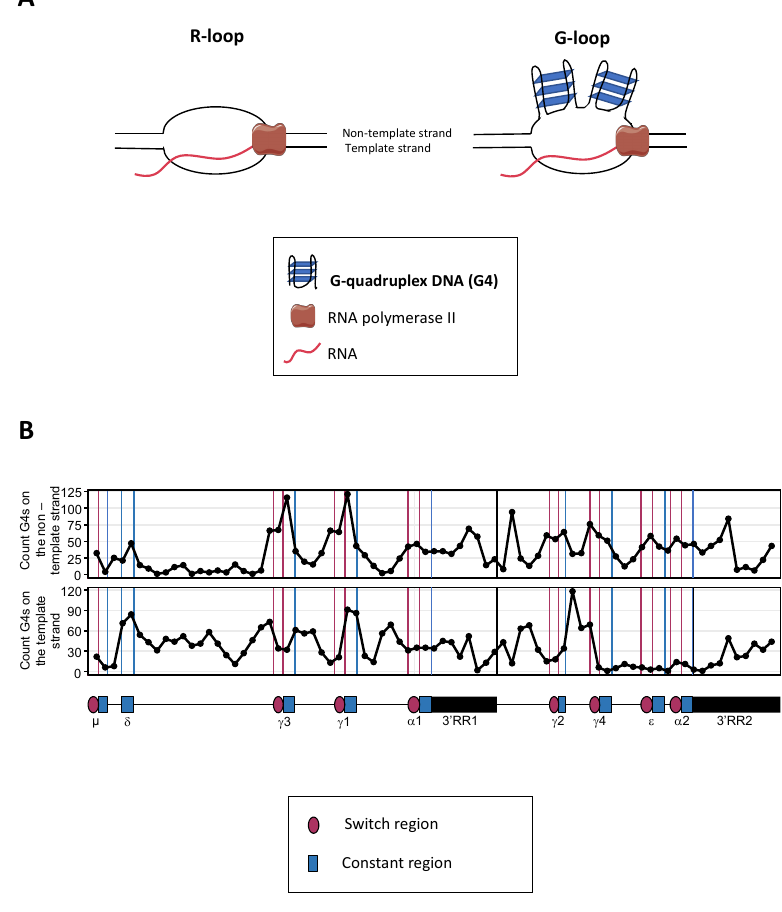
Figure 2. G4s at S regions. ( A ) Schematic representation of R-loops and G-loops. Transcription can create RNA:DNA hybrids, also called R-loops (left). When the nontemplate DNA strand of R-loops is G-rich, it can create G4s, and these structures are then called G-loops (right); ( B ) Representation of G4s located in the human IgH locus constant gene cluster (from Sµ to the end of the 3′RR2) on the coding strand (top) and the template strand (bottom). This representation has been made by processing the IgH sequence with the G4-Hunter algorithm (https://www.g4-society.org/online-tools, accessed on 21 October 2022).